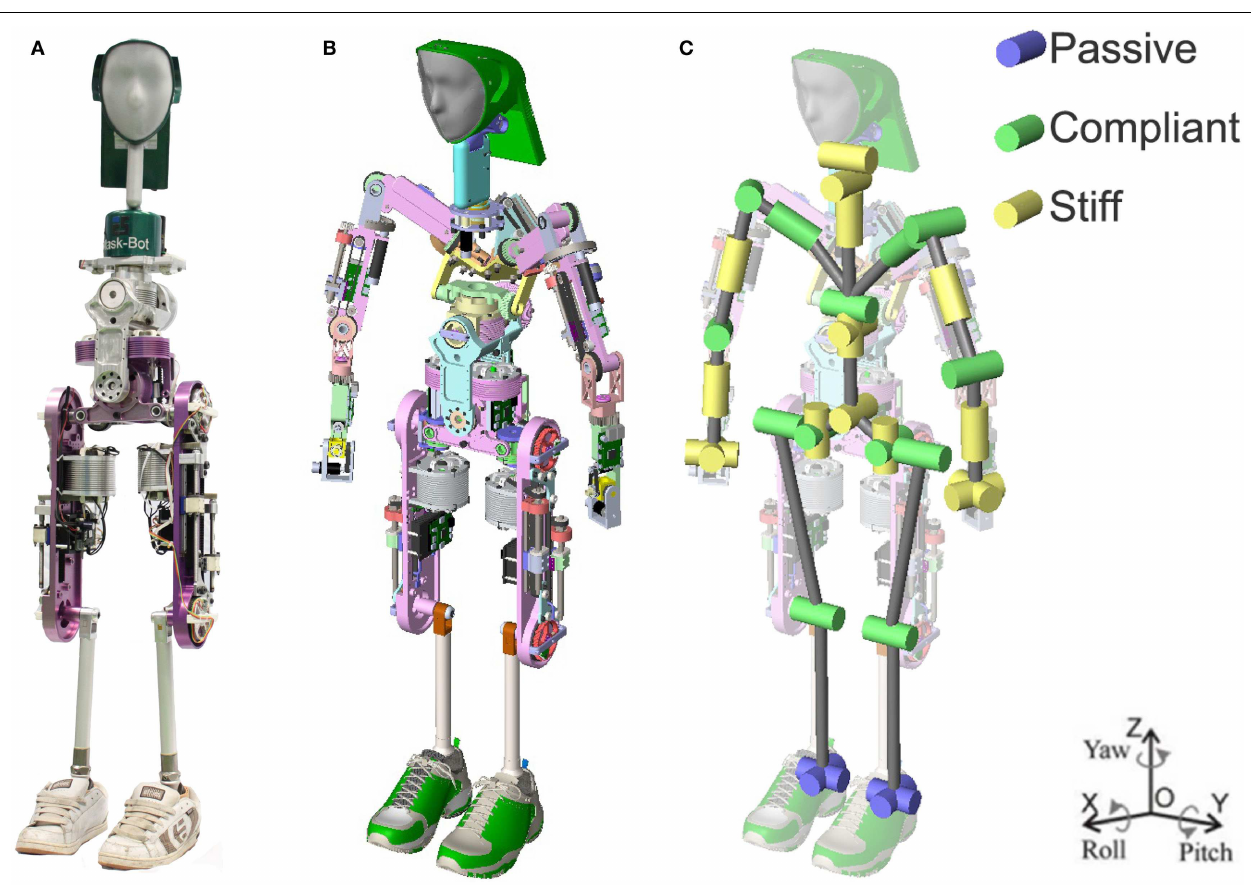
FIGURE 1 | (A) Photo of the current state of Herbert, as used in the physical interaction results section. (B) CAD model of Herbert. (C) The 33 DOFs of the humanoid robot: active (29 DOFs): 2 (cid:2) 1 DOFs knees, 2 (cid:2) 3 DOFs hips, 3 DOFs